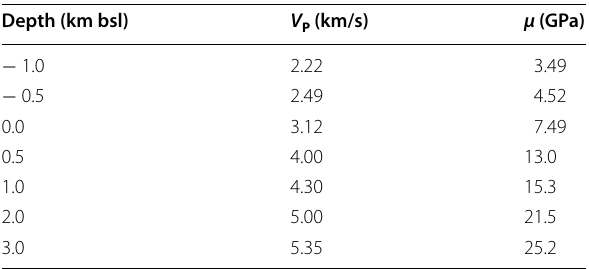
Table 2 One-dimensional P-wave velocity structure of Kuchinoerabu-jima (Yamamoto et al. 2005; Trias- tuty et al. 2009), and calculated modulus of rigidity from Eqs. (1) and (2)